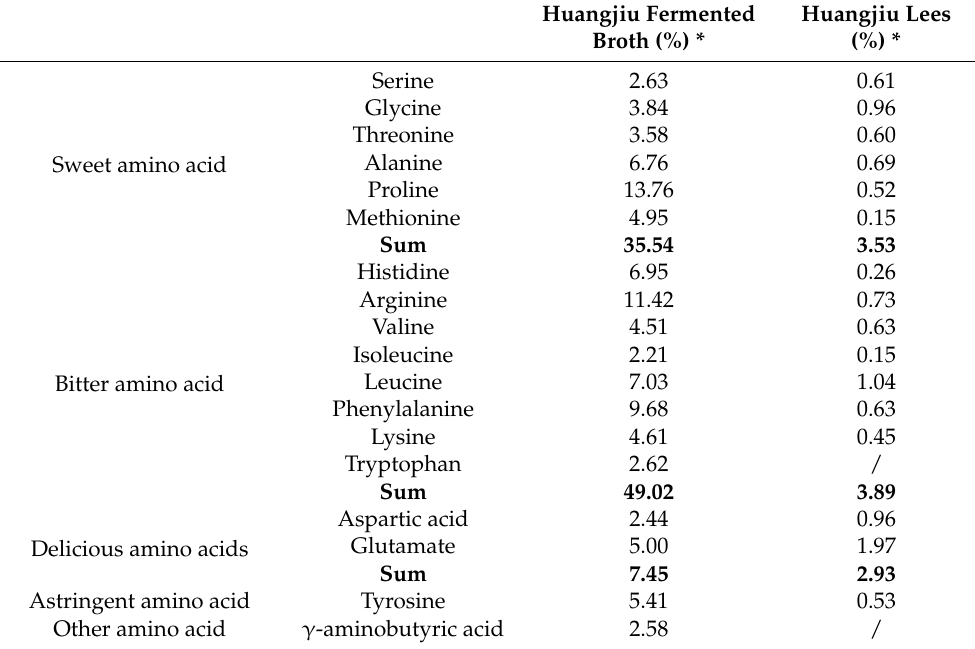
Table 4. Proportion of main flavor amino acids in Huangjiu lees and Huangjiu fermented broth